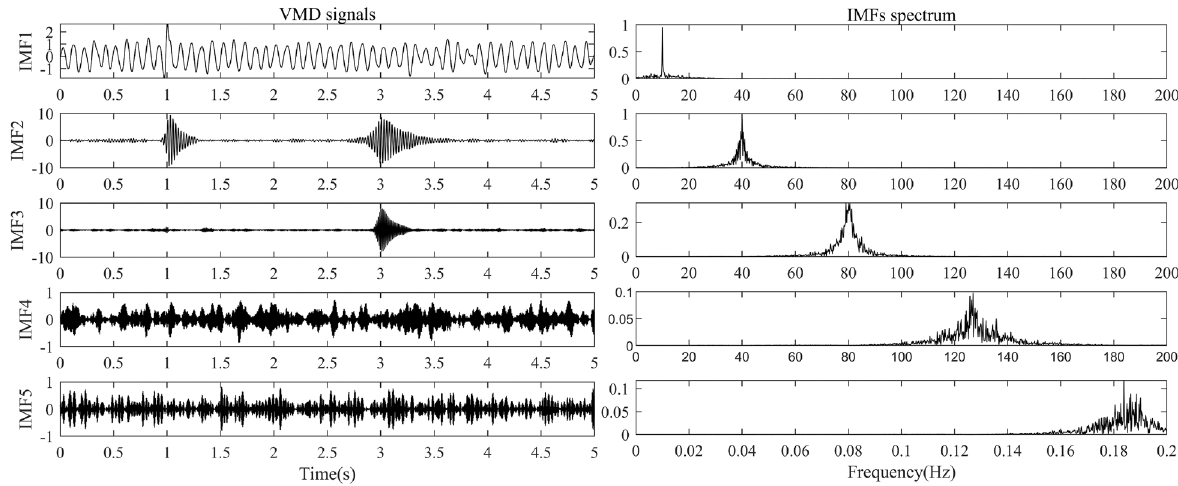
Figure 7 VMD signals and their frequency spectrums